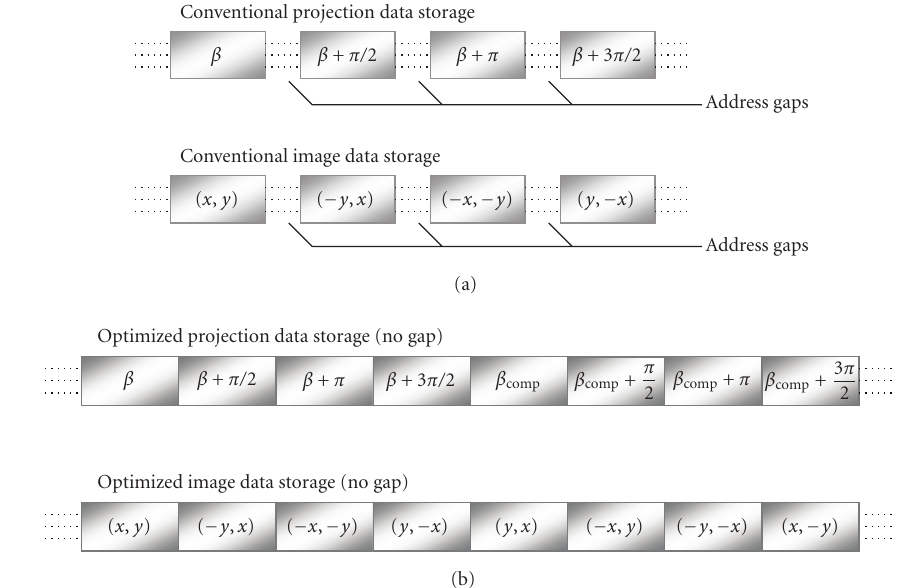
Figure 8: Conventional and our data storage structures: (a) conventional data storage scheme and (b) our optimized storage scheme.